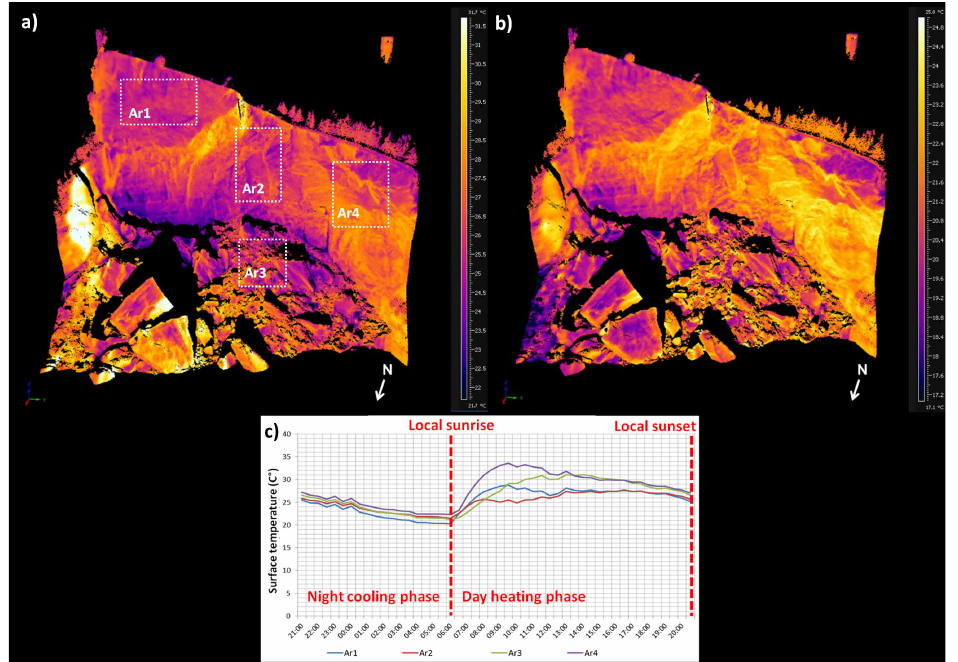
Figure 12. 3D surface temperature maps of the San Leo rock cliff: 11 June 2014, h 20:30 ( a ), 12 June 2014, h 05:00 ( b ), graph showing the 24 h average surface temperature evolution of different rock cliff sectors (Ar1: sound rock; Ar2; Ar4: intensively fractured sectors; Ar3 rock fall deposits) ( c